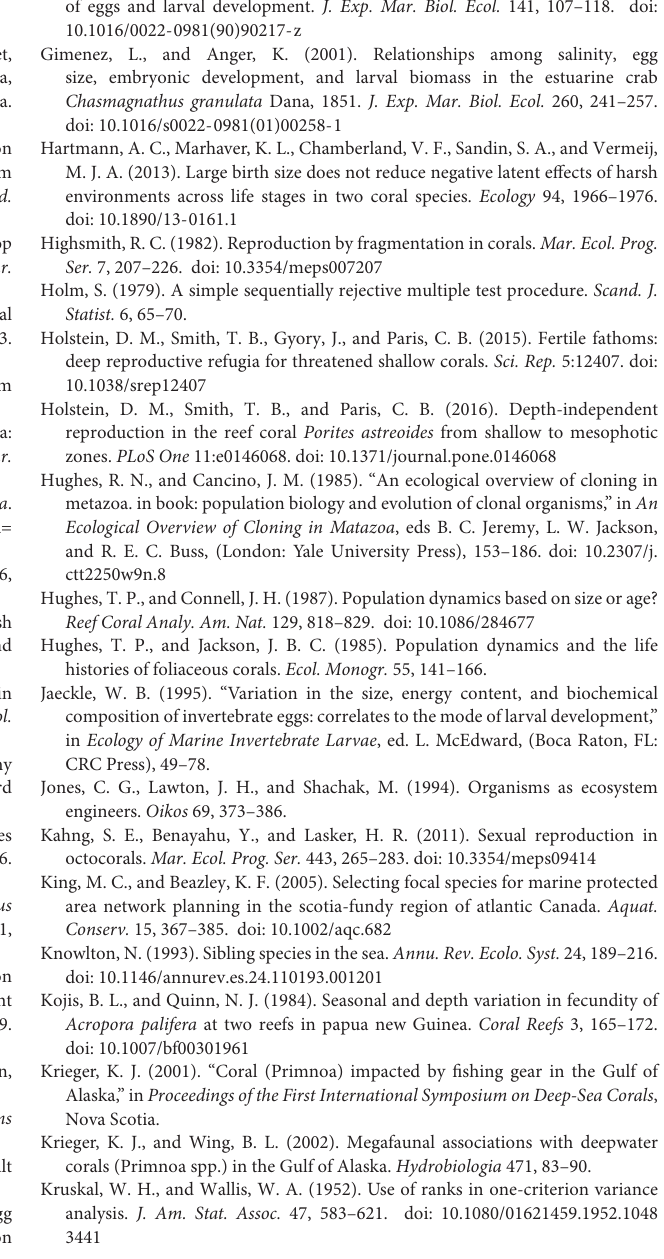
FIGURE S1 | (A) Fecundity for each female arranged by colony depth; (B) The relationship between height of all colonies (both male and female) in this study. Both trend lines are